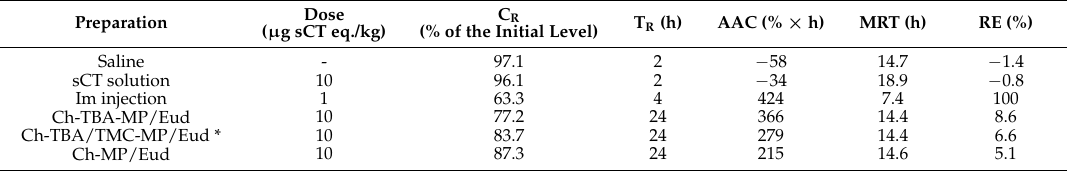
Table 3. Efficacy parameters of Ch-TBA-MP/Eud, Ch-TBA/TMC-MP/Eud and